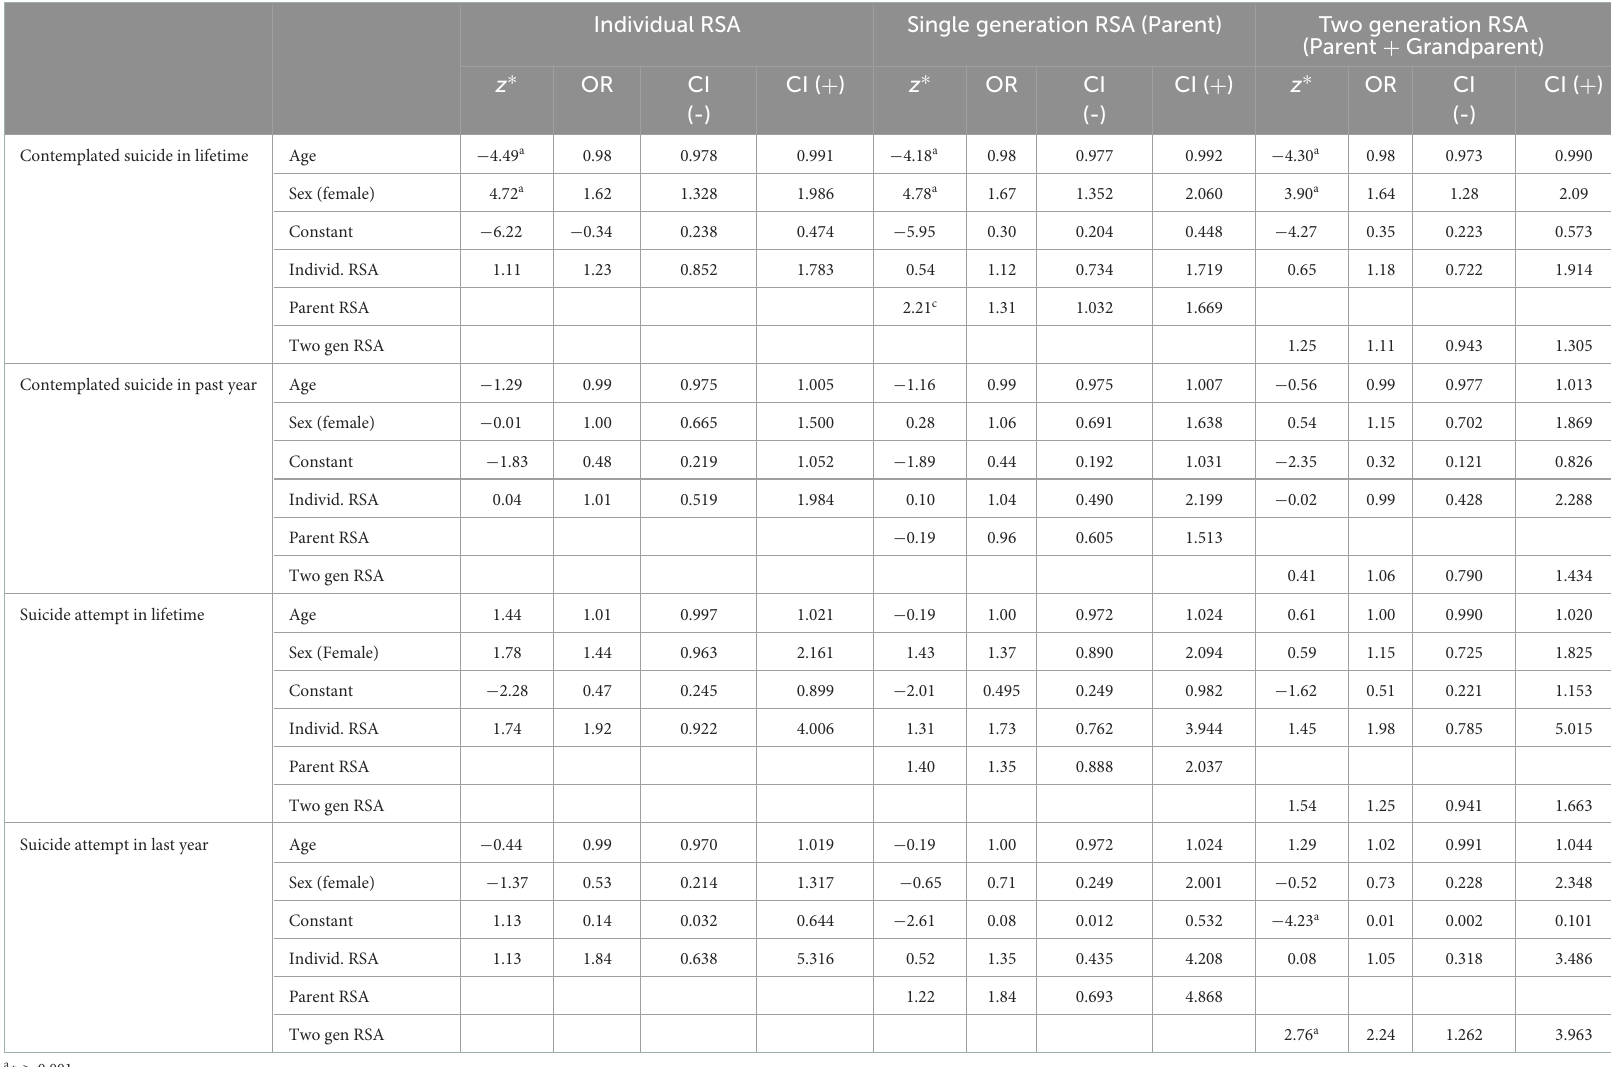
TABLE 5 Predictors of suicide contemplation and attempts including individual, parent, and two-generation